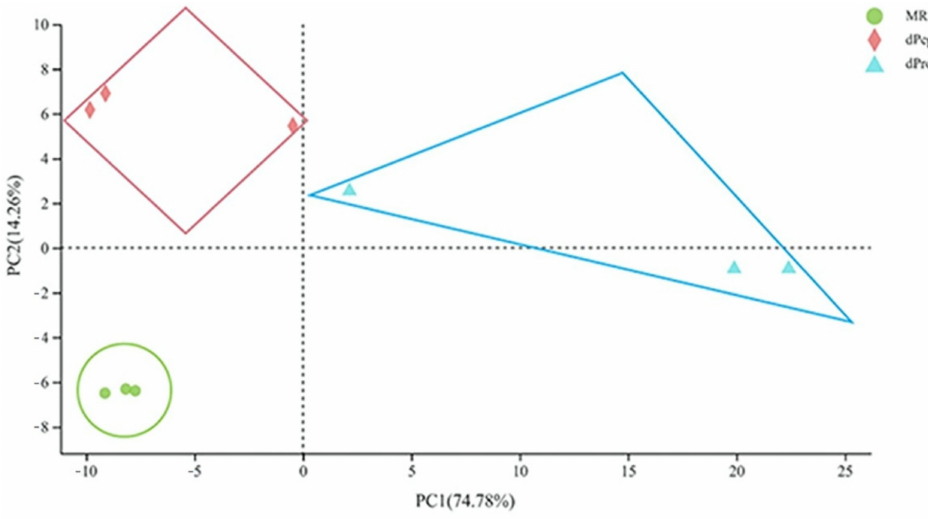
Figure 1. Principal Component Analysis of MRS, dpro and dpep groups ( n =